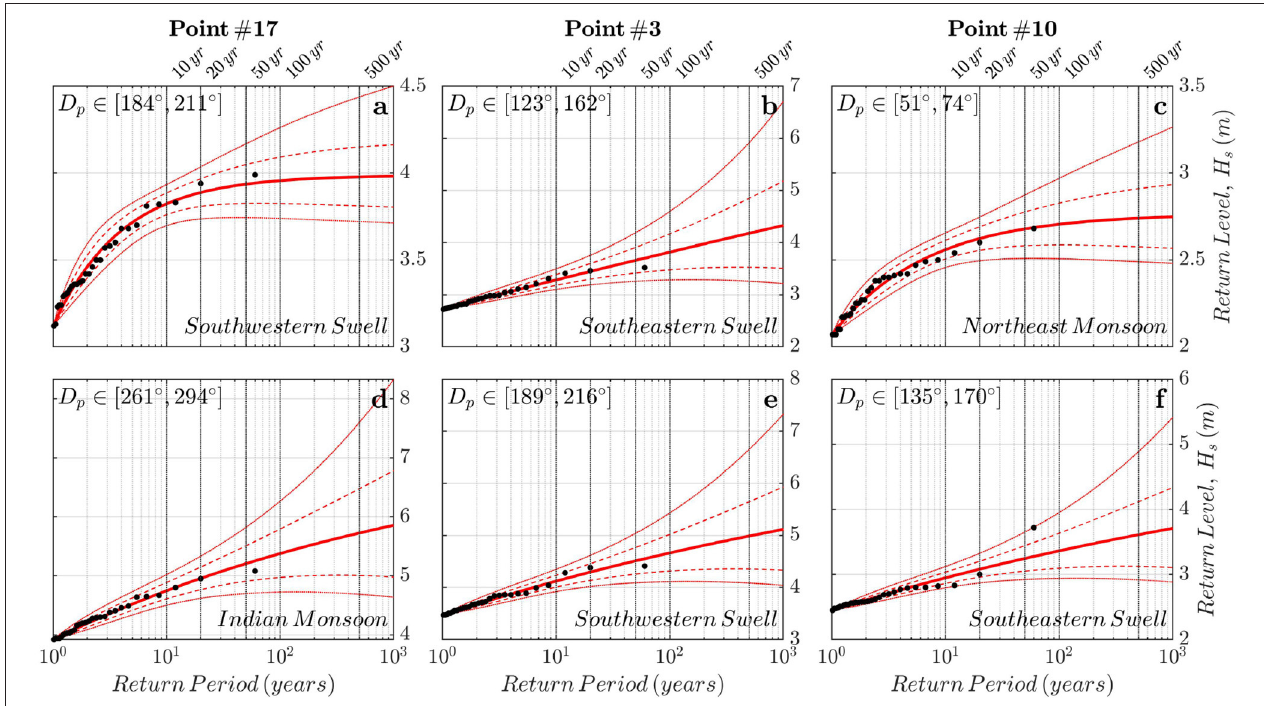
FIGURE 4 | Return levels associated with each return period (thick continuous lines) for the three representative points (point #17 in the first column (a,d) , #3 in the second (b,e) , and #10 in the third) (c,f) for the wave directions identified at each point (for example, panel a corresponds to the first grey shadow in Figure 3a ). The uncertainty bands correspond to ± σ (dashed lines) and the 5 − 95 % intervals (dotted lines) and have been computed using the delta method. The return period indicated in the top of the panels (10, 20, 50, 100, and 500 years) are the ones selected to perform the regional downscaling with WaveWatch III. Note that the y -axis are different for each panel and do not allow a direct comparison.